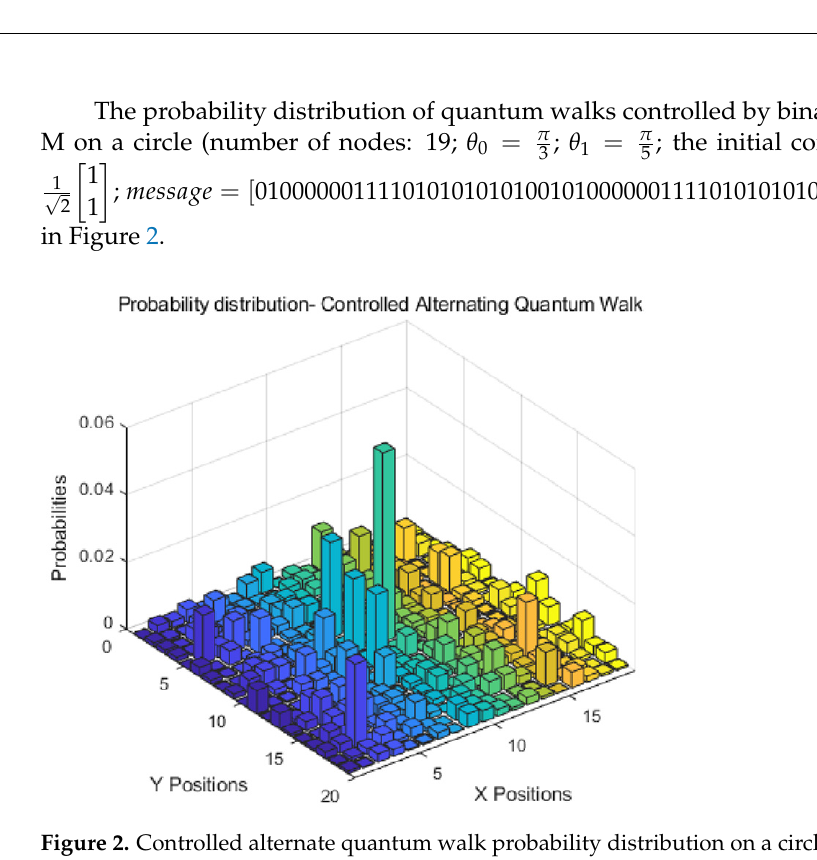
Figure 2. Controlled alternate quantum walk probability distribution on a circle.